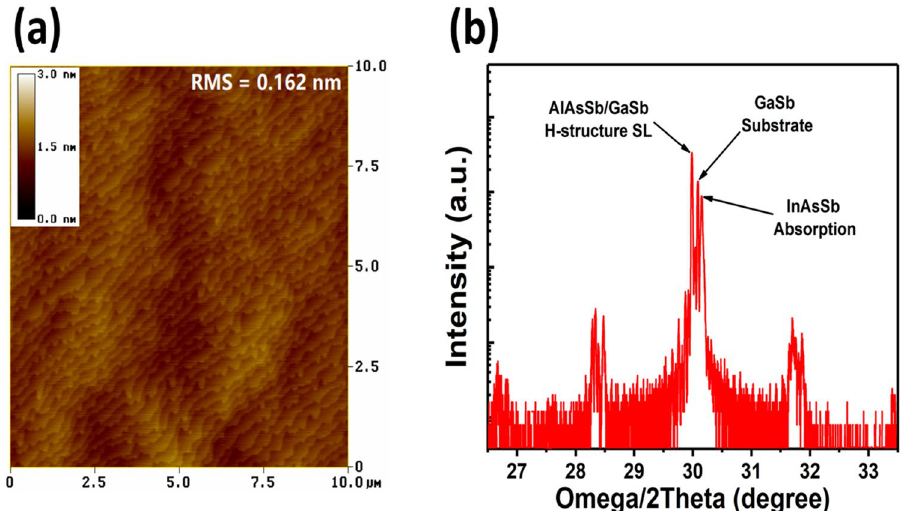
Figure 2. ( a ) The atomic force microscopy image of the grown MWIR APD sample over 10 μm × 10 μm area. ( b ) HR-XRD scan curve of the grown APD sample, where peaks of different regions are marked.